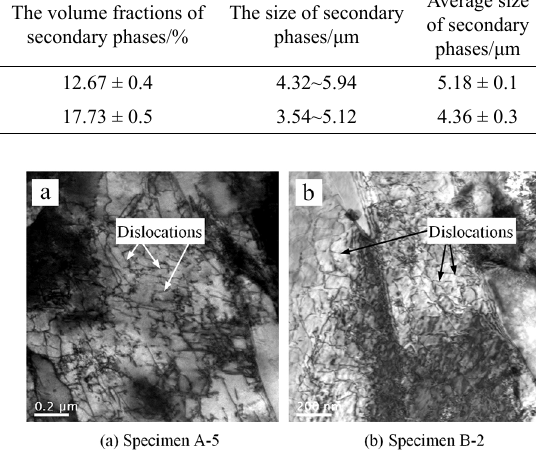
Figure 6. Fractographs of Charpy impact specimens fractured at -10ºC and -15ºC.